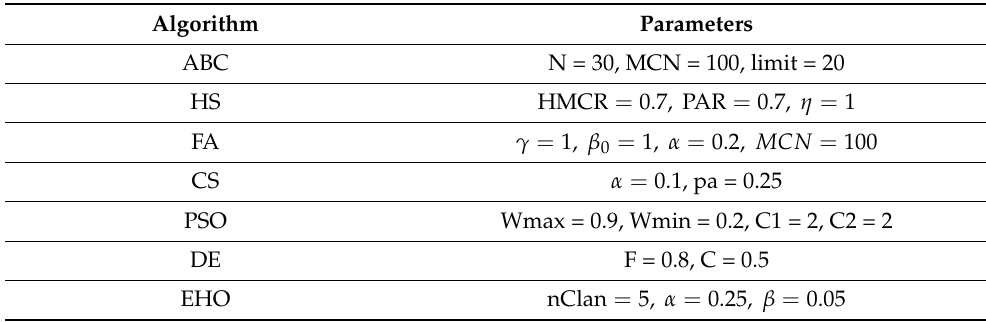
Table 3. Control parameters of all